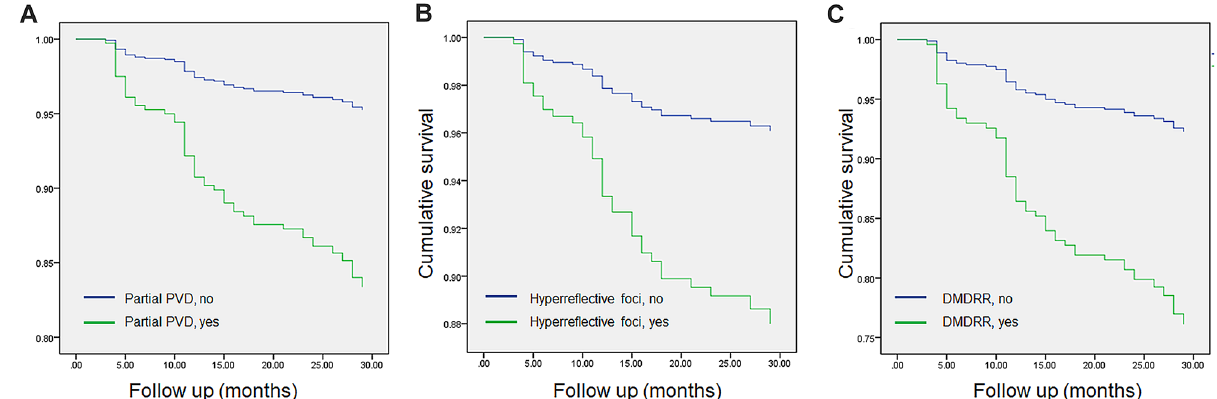
Figure 2. Cox proportional hazard ratio analysis. Cumulative hazards according to ( A ) presence of partial posterior vitreous detachment (PVD); ( B ) hyperreflective foci on inner retinal surface; and ( C ) discrete margin of different retinal reflectivity (DMDRR) in the mid- to far-peripheral retina on ultra-widefield fundus photography.